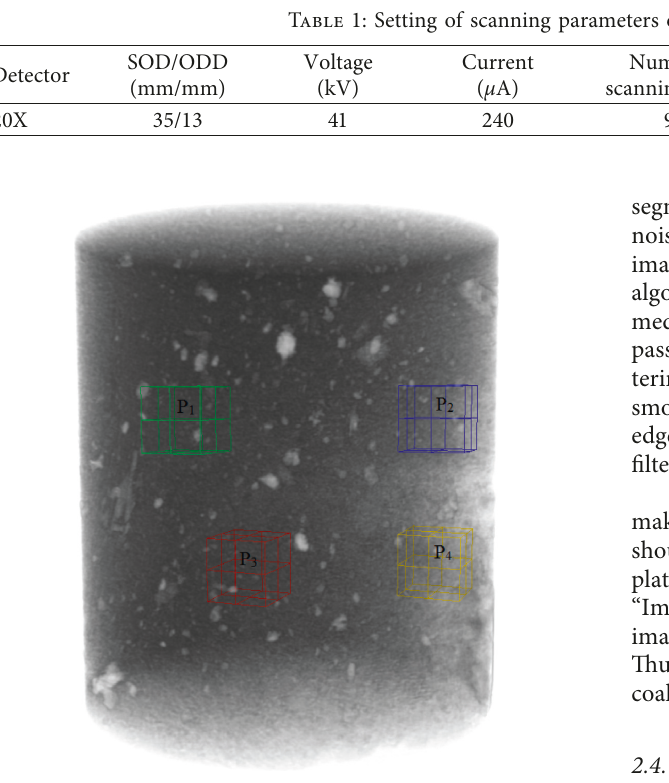
Figure 3: Distribution of the selected models using different points as the voxel